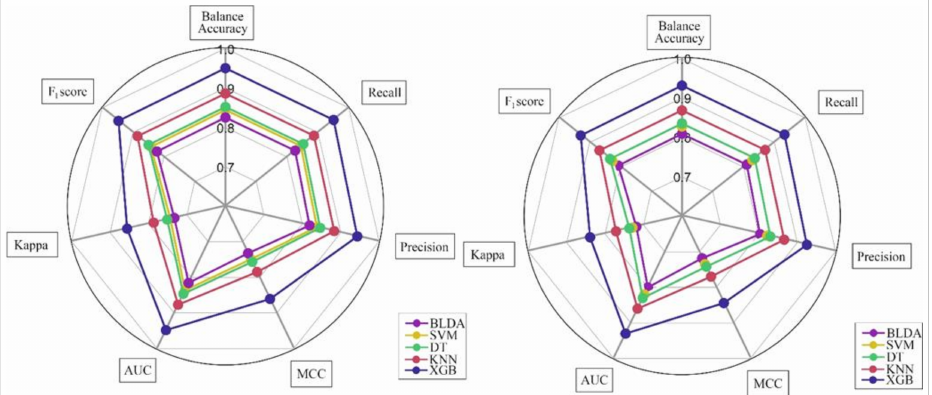
Figure 3. The figure shows the radar plot of the training phase ( left ) and validation ( right ) for the pre- diction of mortality in COVID-19 patients treat to tocilizumab. Abbreviations: AUC: area under curve, MCC: Matthew’s correlation coefficient, XGB: extreme gradient boost, KNN: K-nearest neighbour,